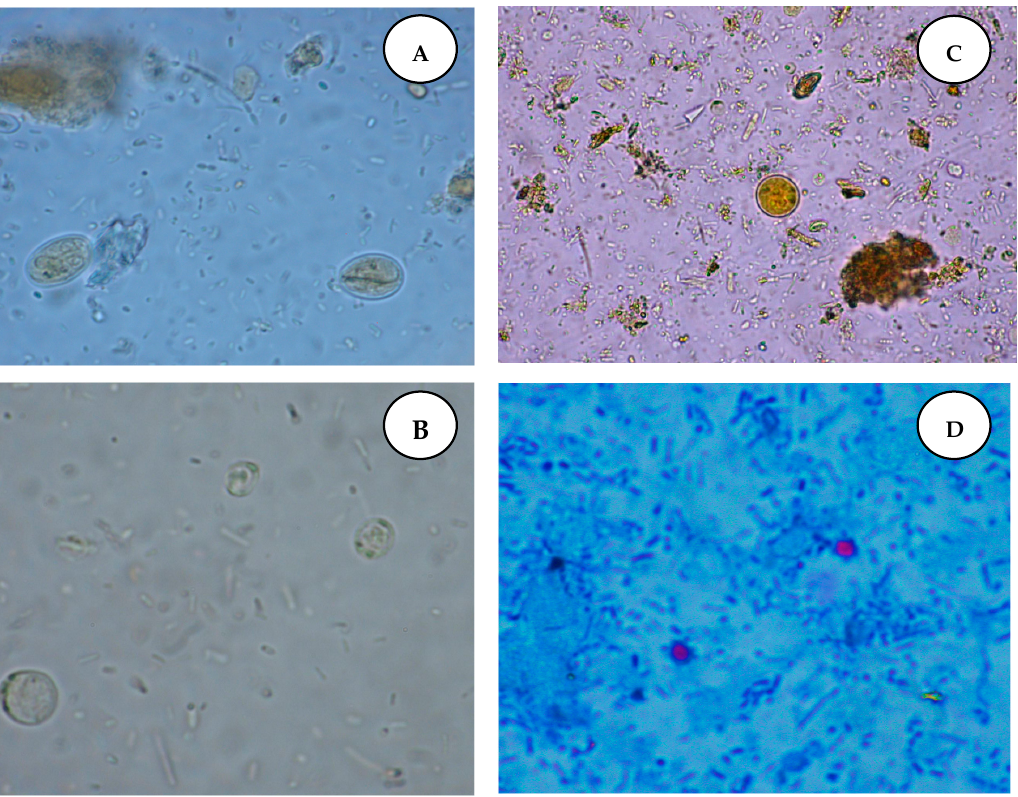
Figure 1. Intestinal parasites identified in stool samples from hematological malignancy patients: ( A ) cyst of Giardia intestinalis ; ( B ) vacuolar forms of Blastocystis spp.; ( C ) cyst of Entamoeba coli in